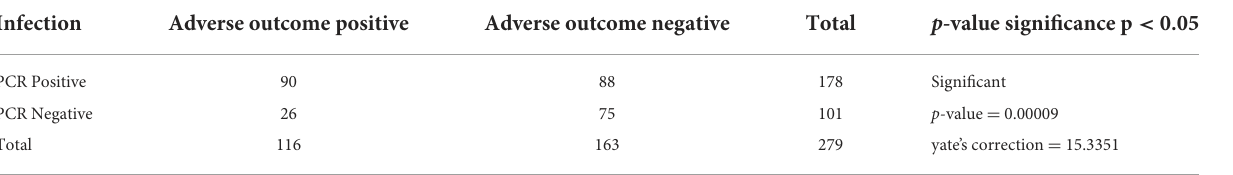
TABLE 2 Correlation between maternal and fetal adverse outcome and infection. Infection Adverse outcome positive Adverse outcome negative Total p -value significance p < 0.05